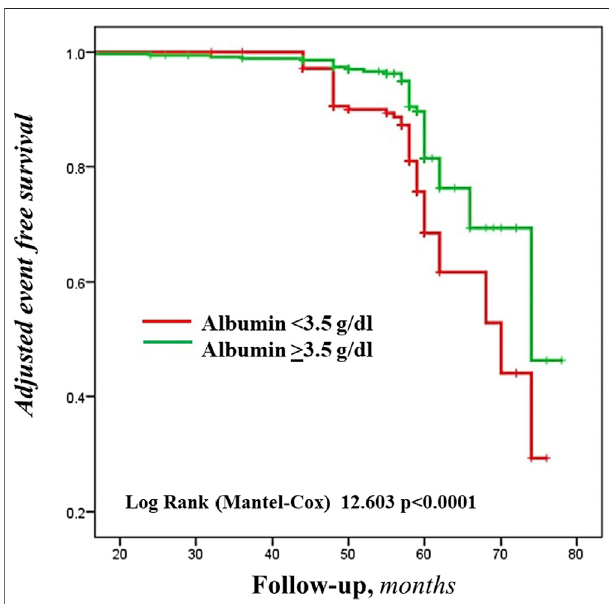
TABLE 3 | Clinical events in the study population according to serum albumin levels.